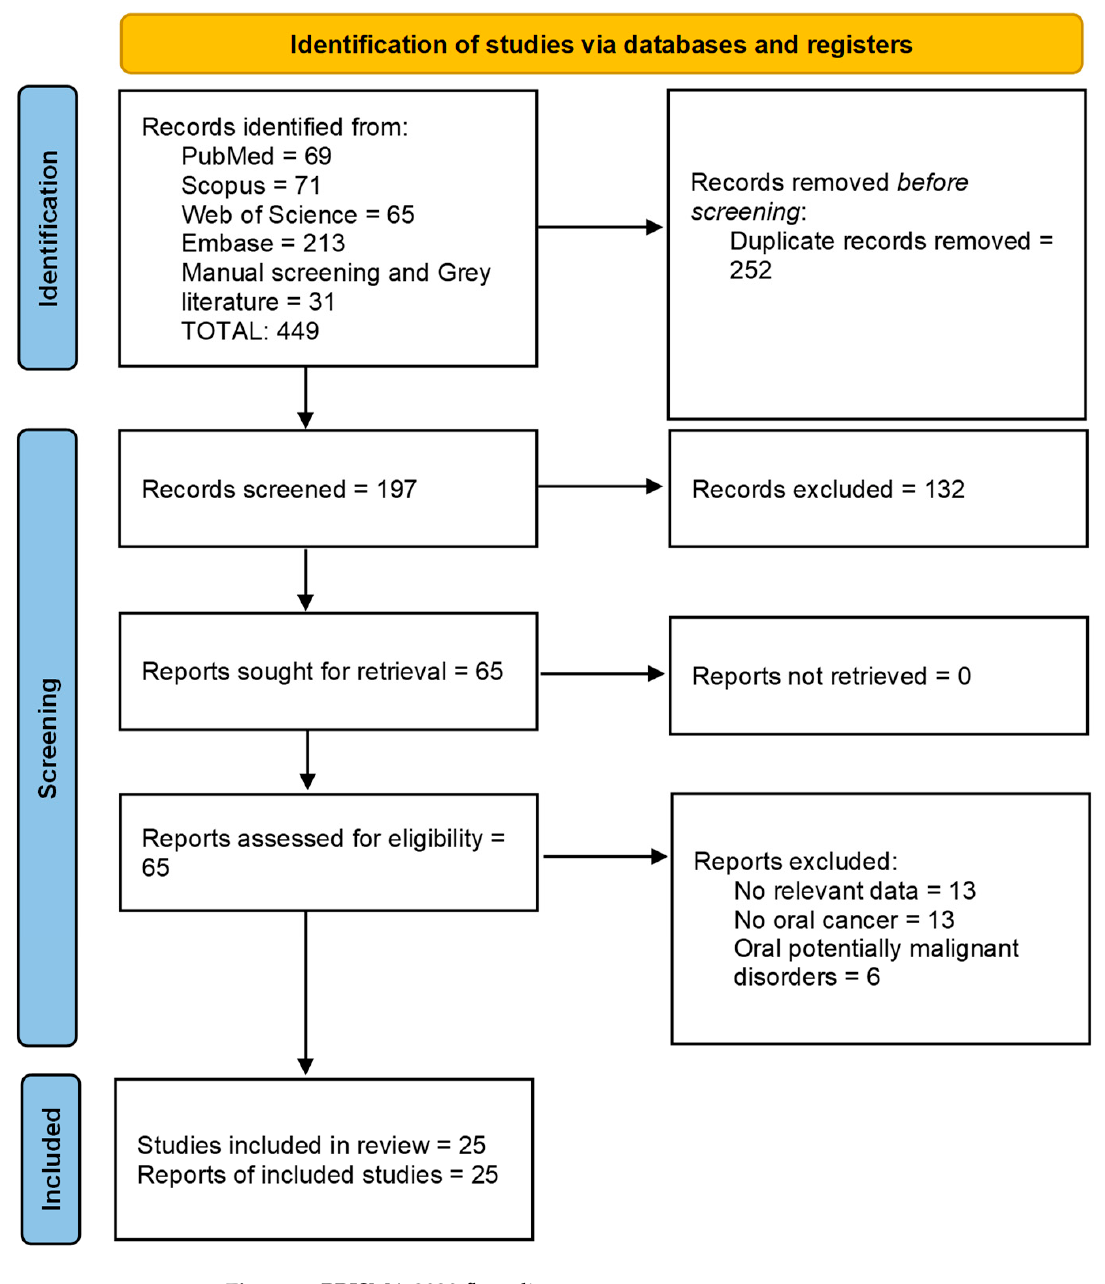
Figure 2. PRISMA 2020 flow diagram.